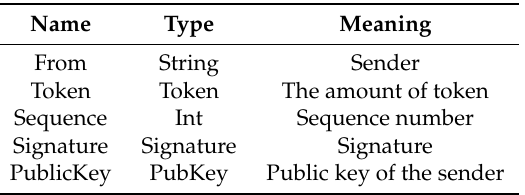
Table 3. Data structure of SendFrom.